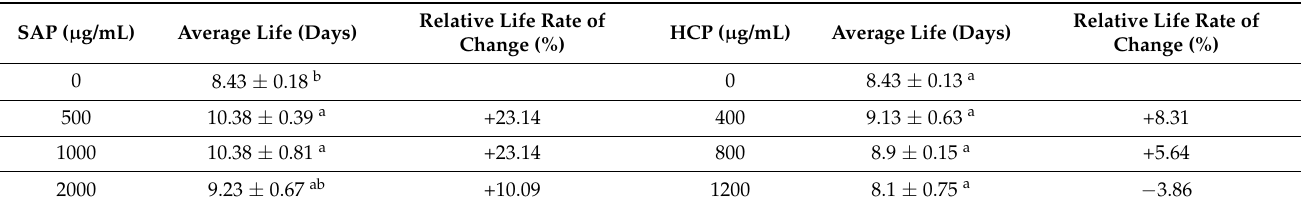
Table 2. The mean lifespan of C. elegans treated with SAP and HCP.